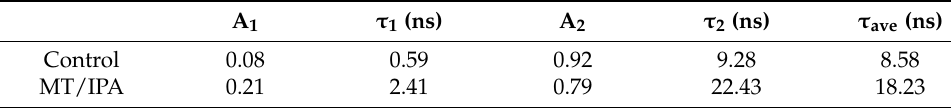
Figure 3. ( a ) XRD spectra of untreated 2D/3D film and MT/IPA-treated 2D/3D film. ( b ) UV-vis absorption spectra of untreated 2D/3D film and MT/IPA-treated 2D/3D film. Spectra of ( c ) PL and ( d ) TRPL for the untreated 2D/3D film and MT/IPA-treated 2D/3D film. Table 1. Fitting results of photoluminescence